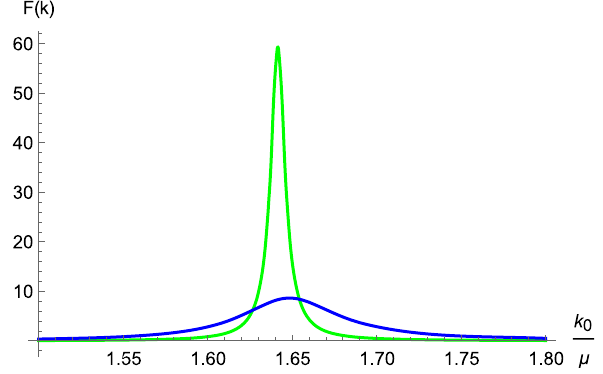
Fig. 5 Variation of the statistical propagator, Eq. (49), with respect to the dimensionless variable k 0 /μ , where we have taken |(cid:5) k | /μ = 1, m /μ = 1 . 3 and the Yukawa coupling strengths g = 0 . 5 (green curve), g = 1 . 3 (blue curve). Comparison with Fig. 4 shows lesser numerical value of the statistical propagator with increasing m /μ . See main text for